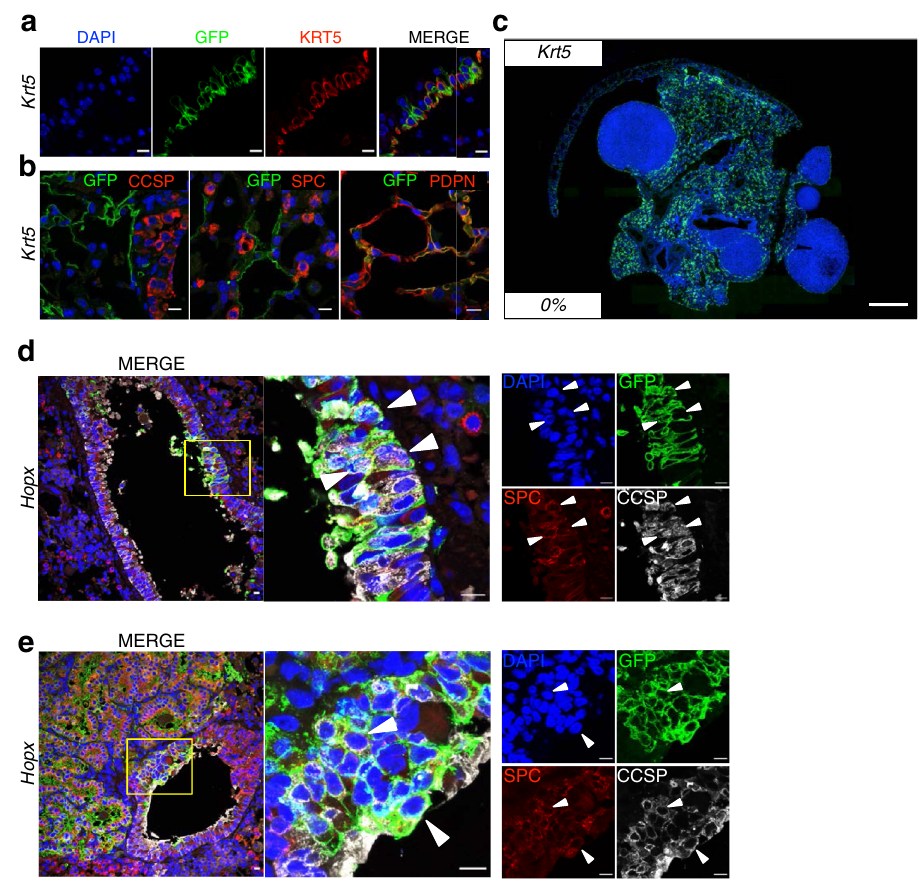
Fig.3|CharacterizationofKrt5andHopxmice.a Immuno fl uorescentstainingof GFP and KRT5 antibodies in the trachea of Krt5 mice showing labelled Basal cells. Overlayand single-channelimagesare sequentially presented. Scale bars: 10 μ m. A minimum of 6 independent animals were analysed. b Immuno fl uorescent staining ofGFPandtheindicatedantibodiesinthedistallungof Krt5 mice.AT1cells,butnot Club or AT2, are labelled. Blue (DAPI), green (GFP), red (as indicated). Scale bars: 10 μ m. A minimum of 6 independent animals were analysed. c Overview of GFP immuno fl uorescent staining in Krt5 mice. The percentage on the lower left corner